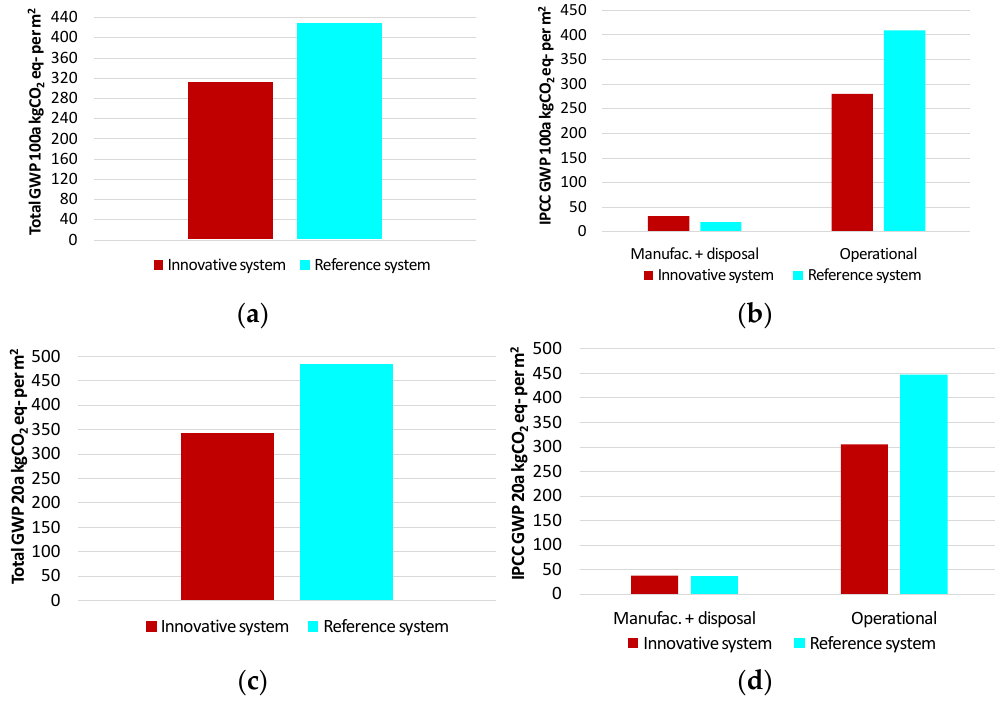
Figure 5. Results per m 2 of living floor using the indicator IPCC GWP–kgCO 2 ‐ eq.: ( a ) GWP 100a per life cycle stage; ( b ) GWP 100a total; ( c ) GWP 20a per life cycle stage; ( d ) GWP 20a total.